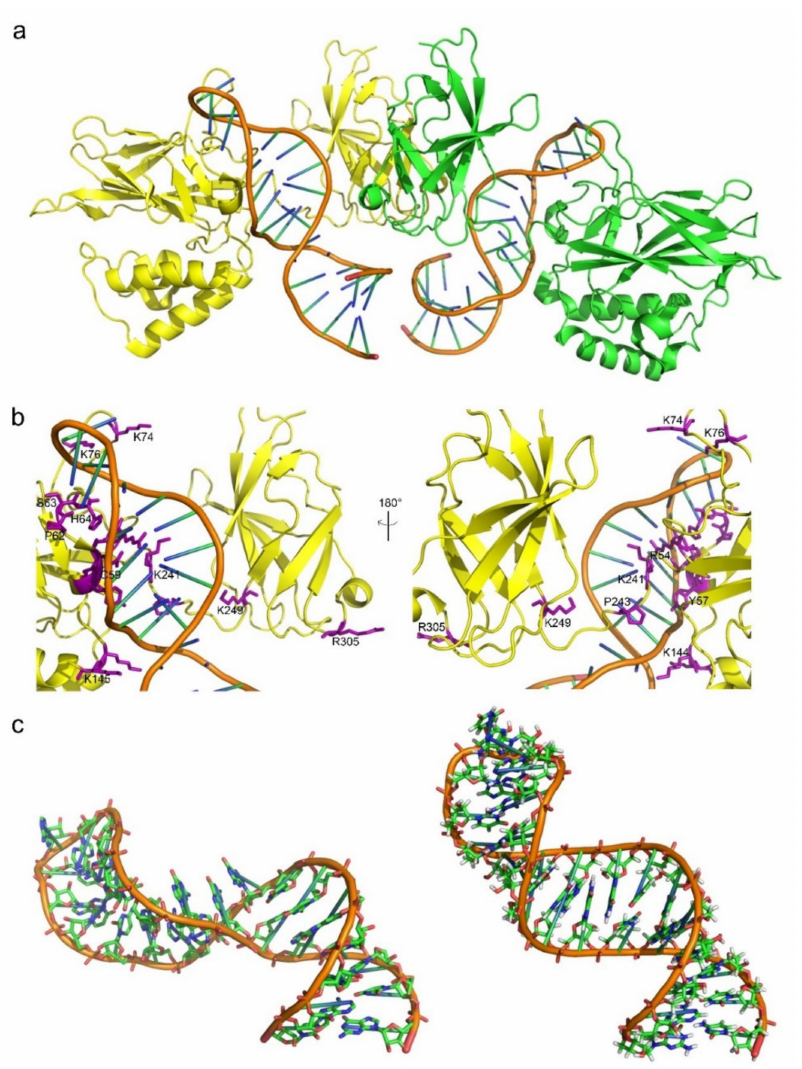
Figure 3. Representation of the state of the aptamer before and after bound to the target protein. ( a ) Anti-NF- κ B RNA aptamer and crystal structure in complex with NF- κ B p502 (PDB ID: 1ooa). In the crystal complex with NF- κ B p502, one aptamer (orange) binds to each NF- κ B subunit (yellow and green) of the dimer. ( b ) The interface of aptamer–protein complex showed the residues contributed to binding. The interaction residues were showed in purple, including mainly positive charged residues (Lys, Arg and His) and non-charged residues (Pro, Tyr and Cys). ( c ) Global structure of the bound ( left ) and free ( right ) anti-NF-kB RNA conformations. Measurement of the global axis curvature using CURVES 5.3 software [79] reveals 39.5 ± 10.08 ◦ and 97 ± 8.08 ◦ helical bend angles for the free (NMR) and protein-bound (crystal) states of the RNA, respectively